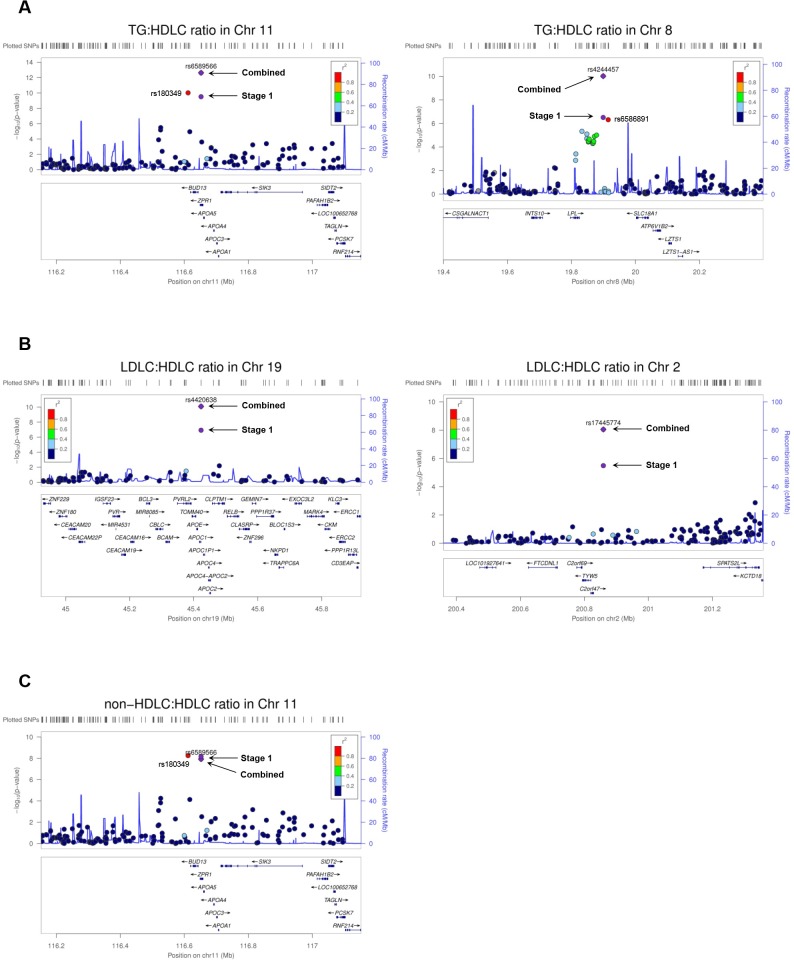
Regional plots of lipid ratios.The plot presents a 1-Mb region centering a peak SNP in each locus for lipid ratio: (A) for log[TG]:HDLC ratio, (B) for LDLC:HDLC ratio, and (C) for non-HDLC:HDLC ratio. Stage1 (blue circle): the association signal of a top SNP in stage 1; combined (blue diamond): the combined signal integrating association results from stage 1 (top SNP) and stage 2.